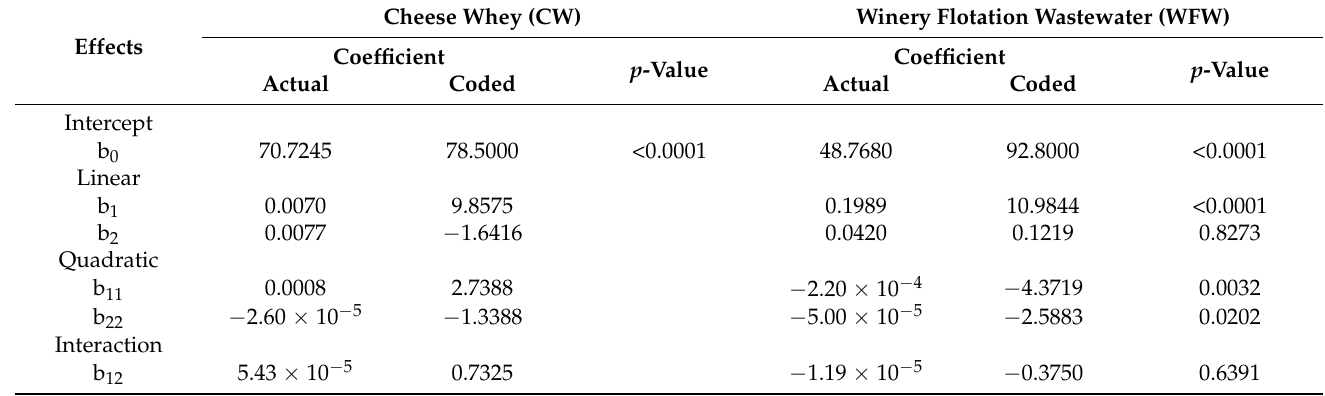
Table 4. Coefficients of regression equations for flocculation